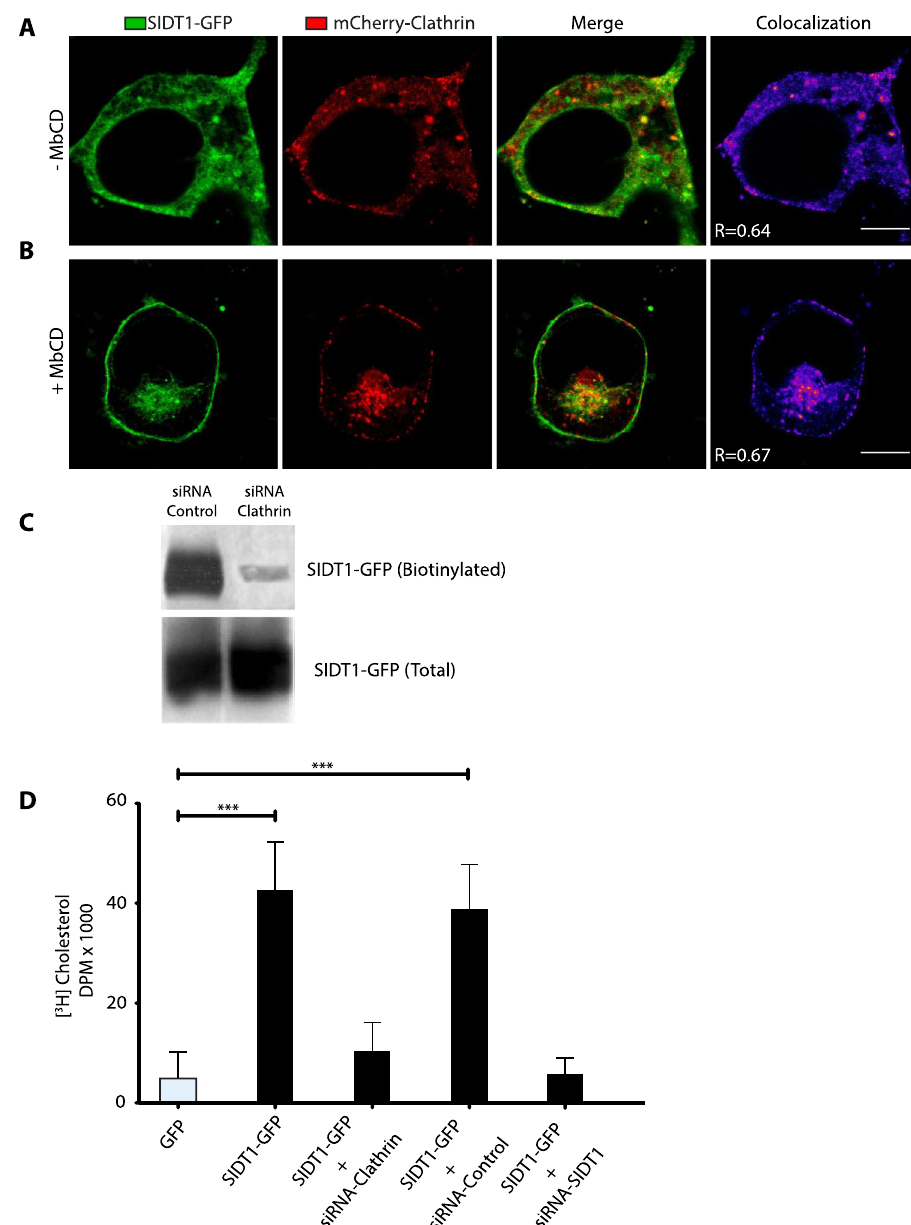
Figure 5. The re-localization of SDIT1 depends on clathrin. Confocal microscopy images illustrating the localization of SIDT1-GFP (green), mCherry-Clathrin (red) and the co-localization panel before ( A ) and after ( B ) M β CD treatment. ( C ) Biotinylation studies illustrating that siRNA against clathrin reduces the amount of SIDT1-GFP biotinylated. Gels were cropped to include all conditions in a single figure and because no other bands were detected in the rest of the gel. ( D ) [ 3 H]-cholesterol uptake in cells treated with a siRNA for clathrin, control (scramble siRNA) or siRNA for SIDT1. *** p < 0.001. Scale bar: 10